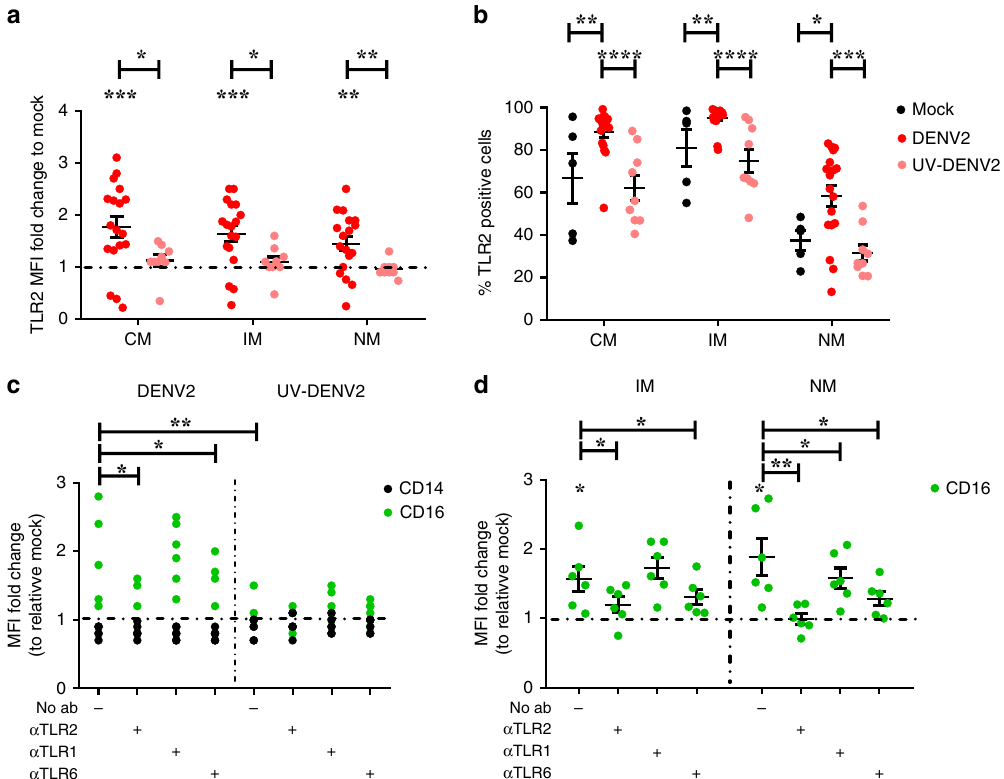
Fig. 3 Active DENV infection upregulates TLR2 and increases CD16 expression in a TLR2/TLR6 dependent manner. PBMCs from healthy donors were (mock-) treated with α TLR2, α TLR1 and α TLR6 (5 µ g/mL) for 2 h prior to infection with DENV2 at MOI of 10 or its UV-inactivated equivalent (UV-DENV2) for 48 h. a MFI of TLR2 expression ( n = 5, fi ve different donors and up to 4 different DENV2 preparations, paired one-tailed t test, * P < 0.05; ** P < 0.01, *** P < 0.001) and b Percenatge of TLR2-positive cells within each of monocytes subset ( n = 5, fi ve different donors and up to four different DENV2 preparations, paired one-tailed t test, * P < 0.05; ** P < 0.01, *** P < 0.001, **** P < 0.0001). c CD14 and CD16 expression were detected for total monocytes in blocking and non-blocking condition ( n = 2, two different donors and three different viral preparations, paired one-tailed t test, * P < 0.05; ** P < 0.01) and d per monocyte subset ( n = 2, two different donors and three different viral preparations, paired one-tailed t test, * P < 0.05; ** P < 0.01). CM